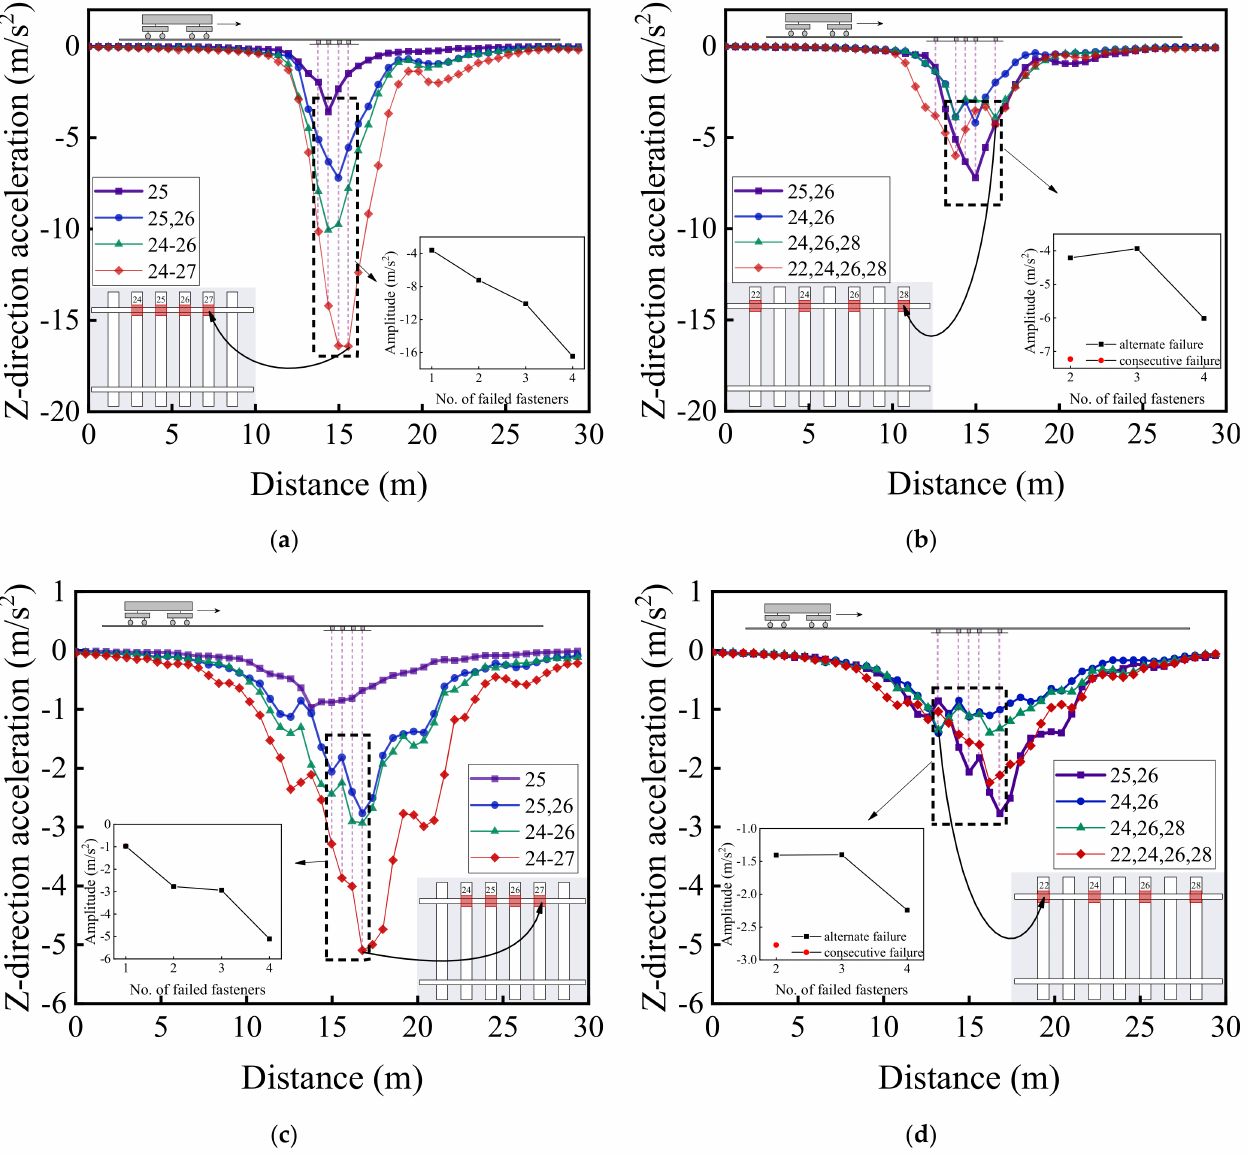
Figure 20. The longitudinal variations of vertical acceleration responses (from No. 1 to No. 50 rail node) of ( a ) the rail at the side with consecutively failed fasteners, ( b ) the rail at the side with alternately failed fasteners, ( c ) the rail at the opposite side of consecutively failed fasteners, and ( d ) the rail at the opposite side of alternately failed